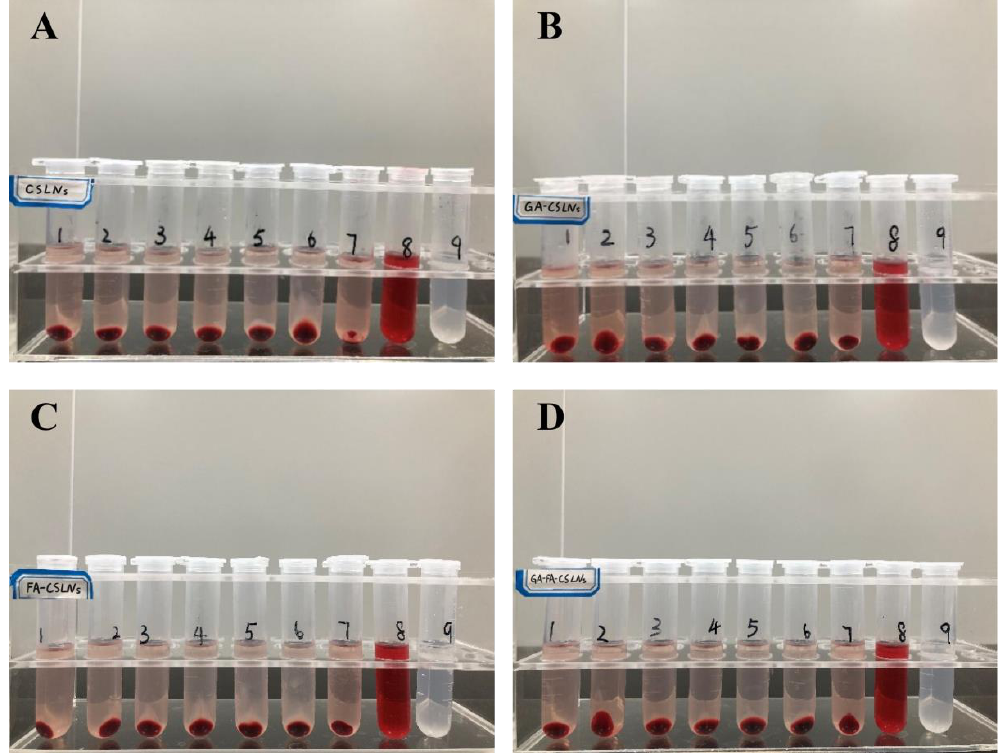
Figure 4. Hemolysis assessment of SLNs ( A ) CSLNs; ( B ) GA-CSLNs; ( C ) FA-CSLNs; and ( D ) GA-FA-CSLNs.